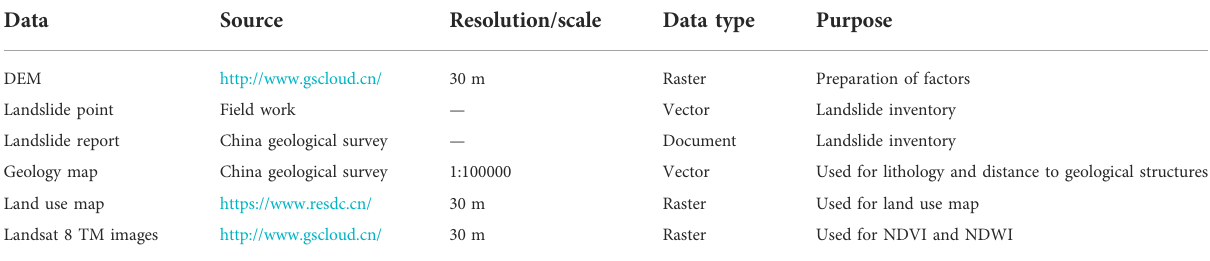
TABLE 1 The data sources used in this study and their detailed